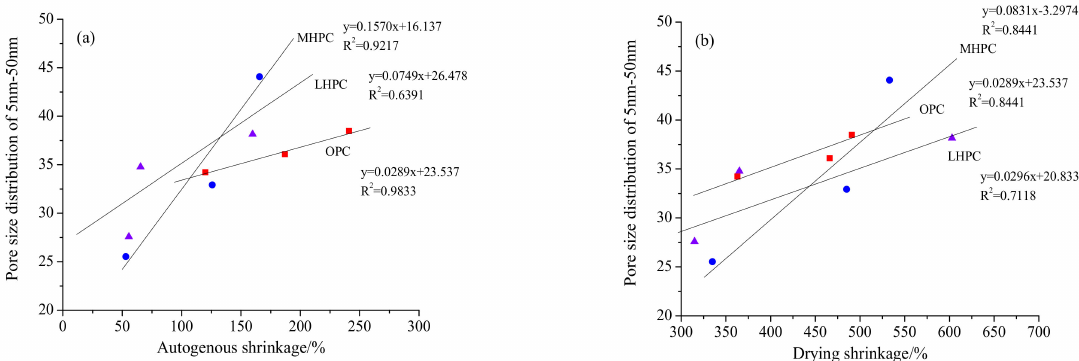
Figure 14. Relationship between shrinkage behavior and pore size distribution of 5 nm–50 nm of mortars with different alkali sulfates contents. ( a ) Autogenous shrinkage; ( b ) drying